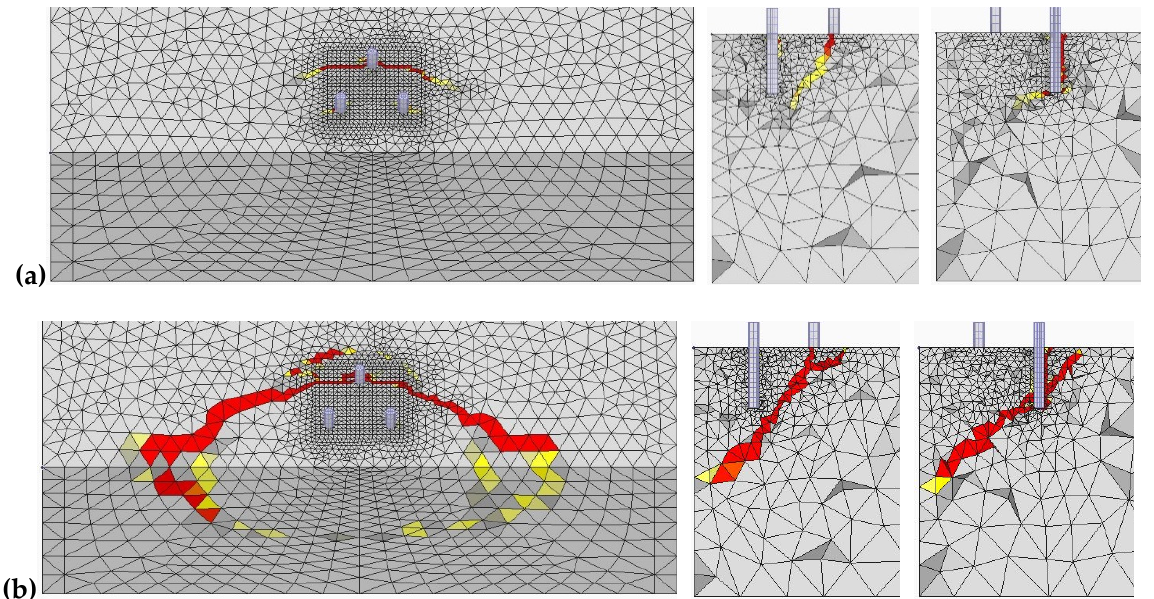
Figure 7. Crack pattern obtained from numerical analysis for Group Tri-A loaded perpendicular to the edge ( a ) at peak load, and ( b ) in post-peak phase.